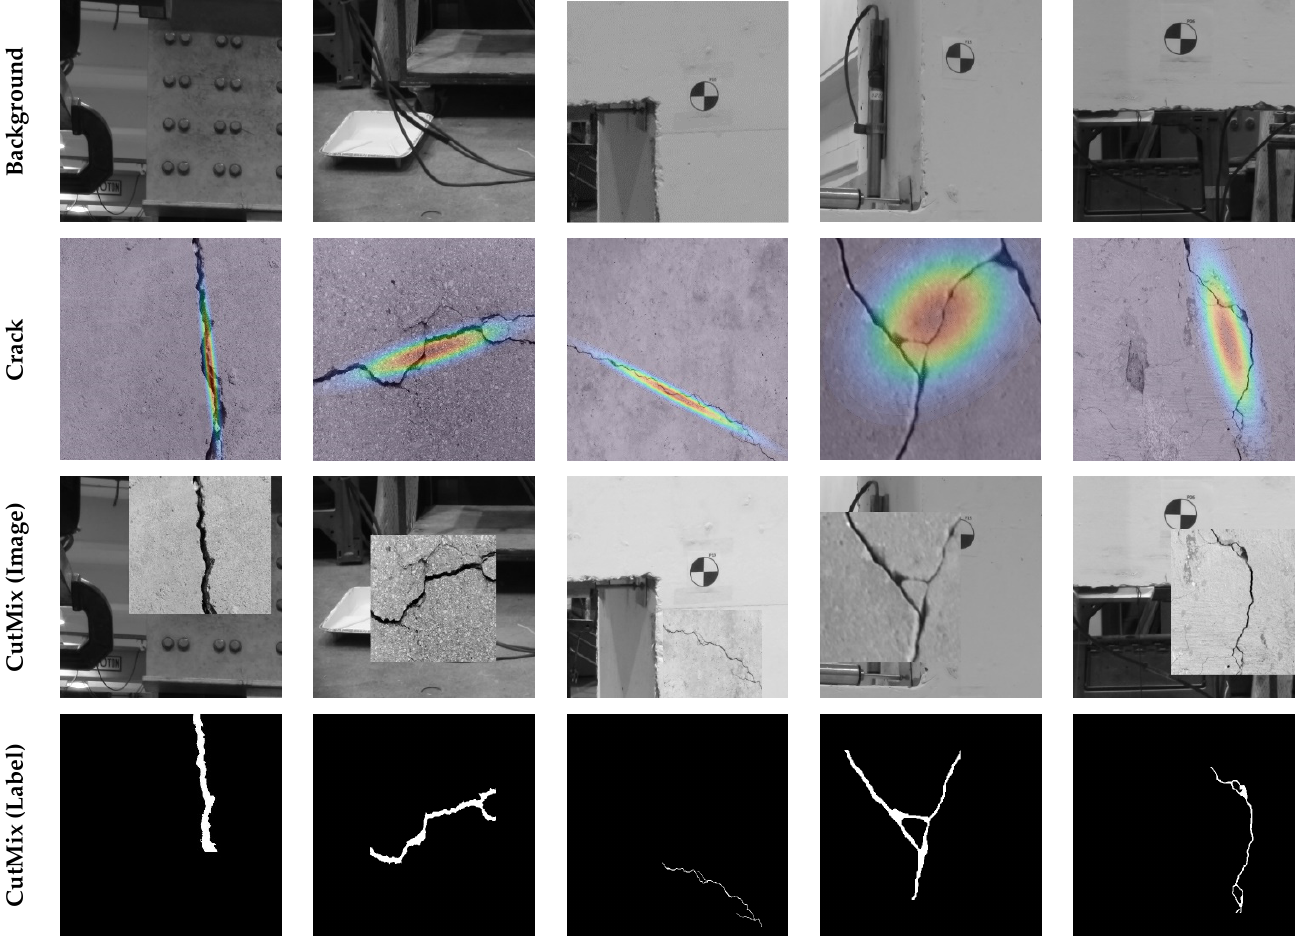
Figure 12. Samples of images and labels generated through the proposed CutMix data synthesis.